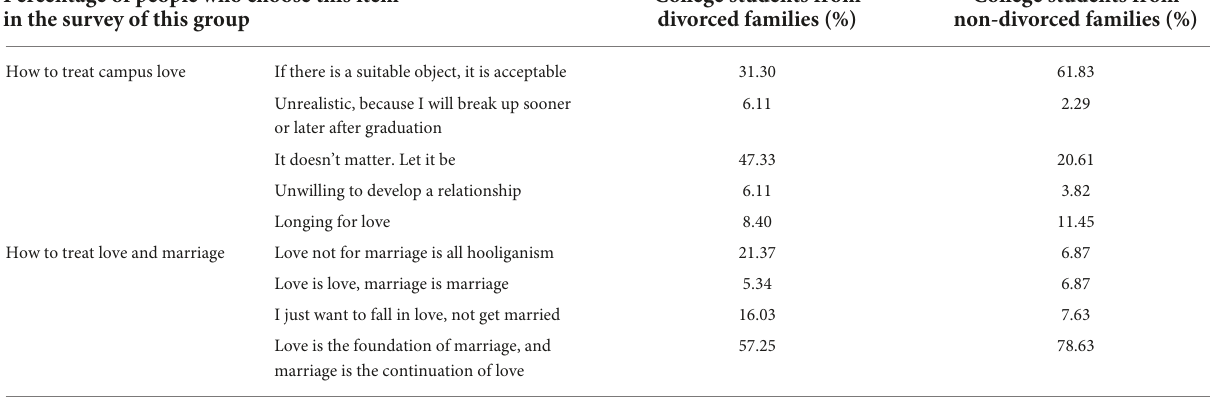
TABLE 4 Partial survey data on independence.